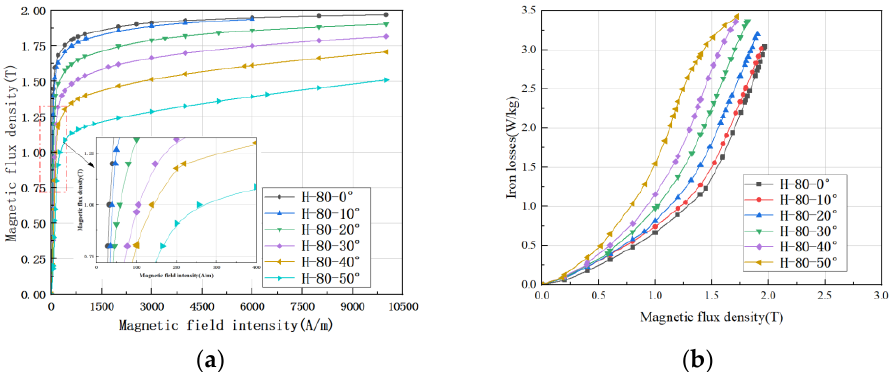
Figure 9. Magnetic characteristics of grain-oriented silicon steel at different angles ( a ) magnetization curves of H-80 material at different angles @50 Hz; ( b ) iron loss curves of H-80 material at different angles @50 Hz.